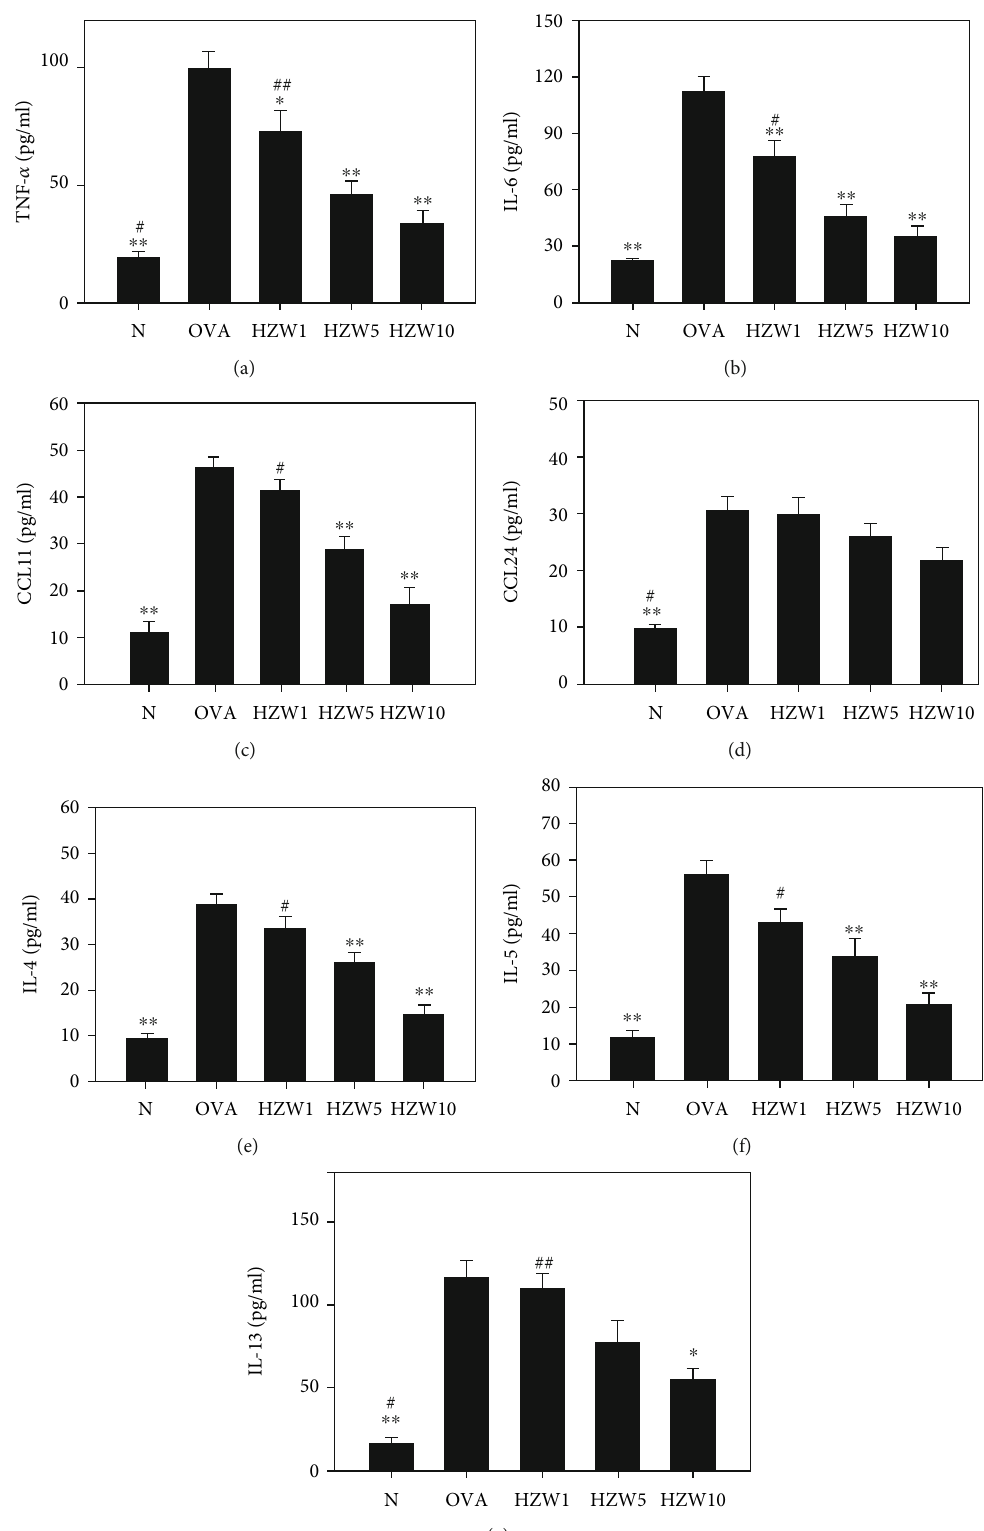
Figure 8: The e ff ects of HZW on the levels of cytokines and chemokines in the BALF. The concentrations of TNF- α (a), IL-6 (b), CCL11 (c), CCL24 (d), IL-4 (e), IL-5 (f), and IL-13 (g) were measured by ELISA. All data are presented as the mean ± SEM . ∗ P < 0 : 05 and ∗∗ P < 0 : 01 compared with the OVA control group. # P < 0 : 05 and ## P < 0 : 01 compared to the HZW10